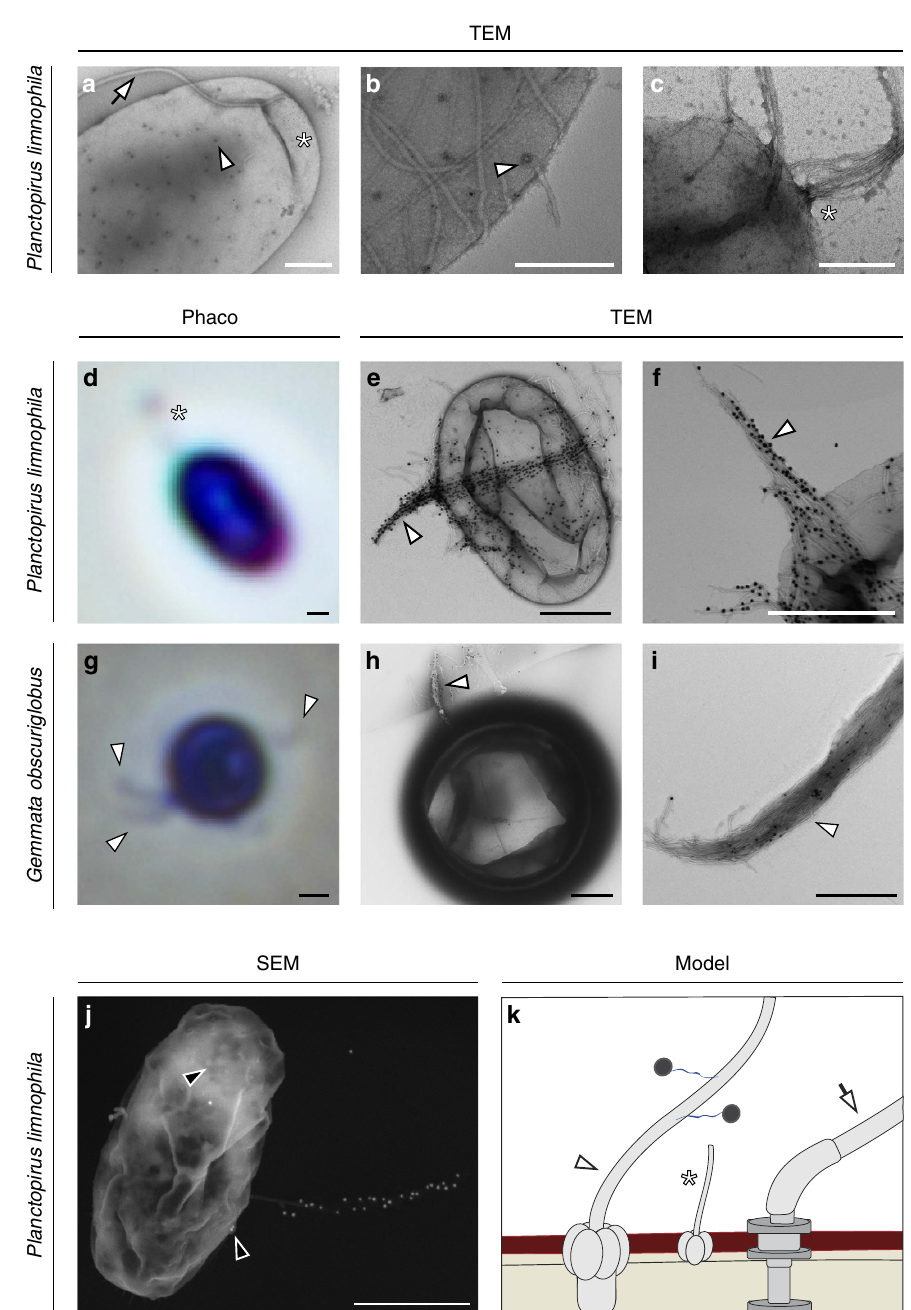
Figure 6 | Planctopirus limnophila and Gemmata obscuriglobus possess fibres that bind to dextran. ( a – c ) TEM analysis of P. limnophila cells revealed multiple distinct appendages. The flagellum ( a , white arrow) with a diameter of 22nm is typical for bacteria. In contrast, large- ( a , b , white arrowheads) and small crateriform structures ( a , c , asterisk) are unique to the Planctomycetes and form pili with diameters of 12nm ( b ) 6nm ( c ) respectively. The polar thinner fibres ( a , c , asterisks) form a stalk that attaches the cell to a surface or is involved in cell aggregation. Scale bars, 0.2 m m. ( d – i ) Light microscopic phase contrast ( d , g , Phaco) and TEM ( e , f , h , i ) micrographs of P. limnophila ( d – f ) and G. obscuriglobus cells ( g – i ) fed with gold-labelled dextran (four individual experiments). In the light microscope ( d , g ) either the stalk of P. limnophila (asterisk), that is associated with the small crateriform structures ( c ), or the fibres of G. obscuriglobus associated with the large crateriform structures ( b , white arrowheads) are visible. TEM analysis revealed dextran binding to fibres of both species ( e , f , h , i ). ( j ) Backscattered electron detection in the SEM micrograph shows electron dense gold particles as bright dots and illustrates that fibre bundles can even be longer than the entire cell body. Some gold particles appear to be internalized by the cell ( j , black arrowheads). The scheme ( k ) shows the flagella/attachment pole of a P. limnophila cell, which is opposite to the reproduction pole where cell division through budding takes place. While small crateriform structures are localized only close to the flagellum and produce the stalk (asterisk), fibres associated with the large crateriform structures are distributed throughout the cell (white arrowheads). Scale bars, 0.5 m